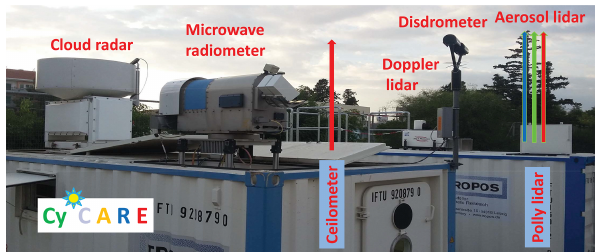
Figure 2. LACROS (Leipzig Aerosol and Cloud Remote Observa- tions System) deployed at Limassol, Cyprus, from 22 October 2016 to 26 March 2018 in the framework of the CyCARE field campaign. LACROS belongs to Cloudnet and consists of a 35GHz Doppler cloud radar, microwave radiometer, disdrometer (on the roof of the cloud container), and 1.5µm wind Doppler lidar on the roof of the aerosol container and a multiwavelength polarization/Raman lidar (Polly) within the aerosol container. A ceilometer (1064nm wave- length) was deployed between the cloud and aerosol containers (not visible in the photograph).